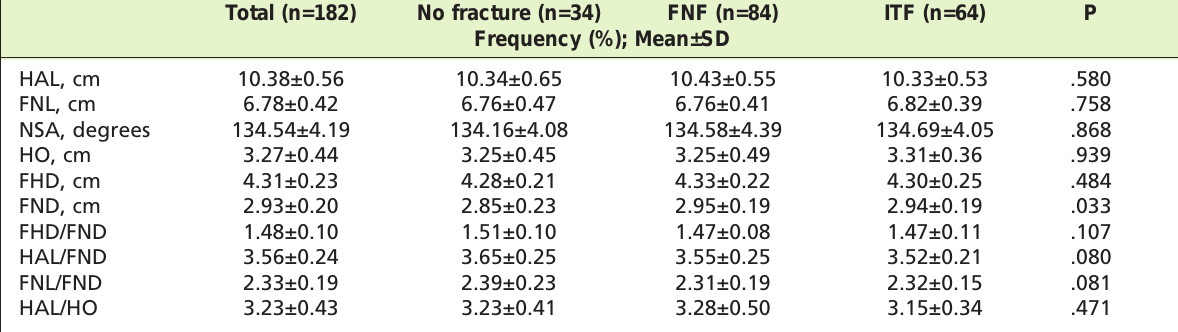
Radiologic hip geometry of patients (n=182) Table II: